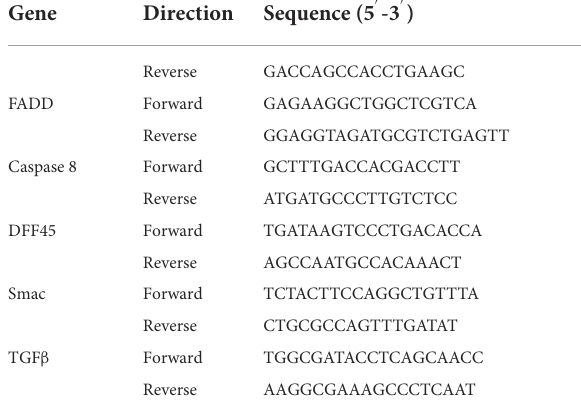
TABLE 1 Primers used for real-time